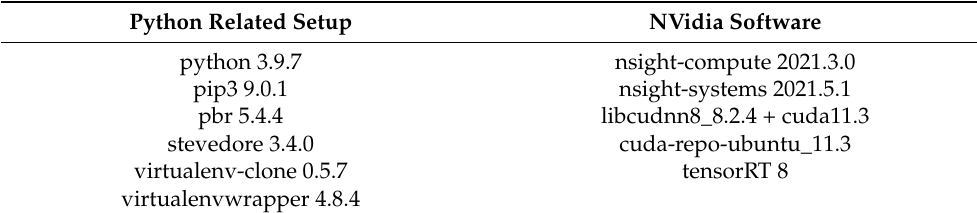
Table A1. Installed software.